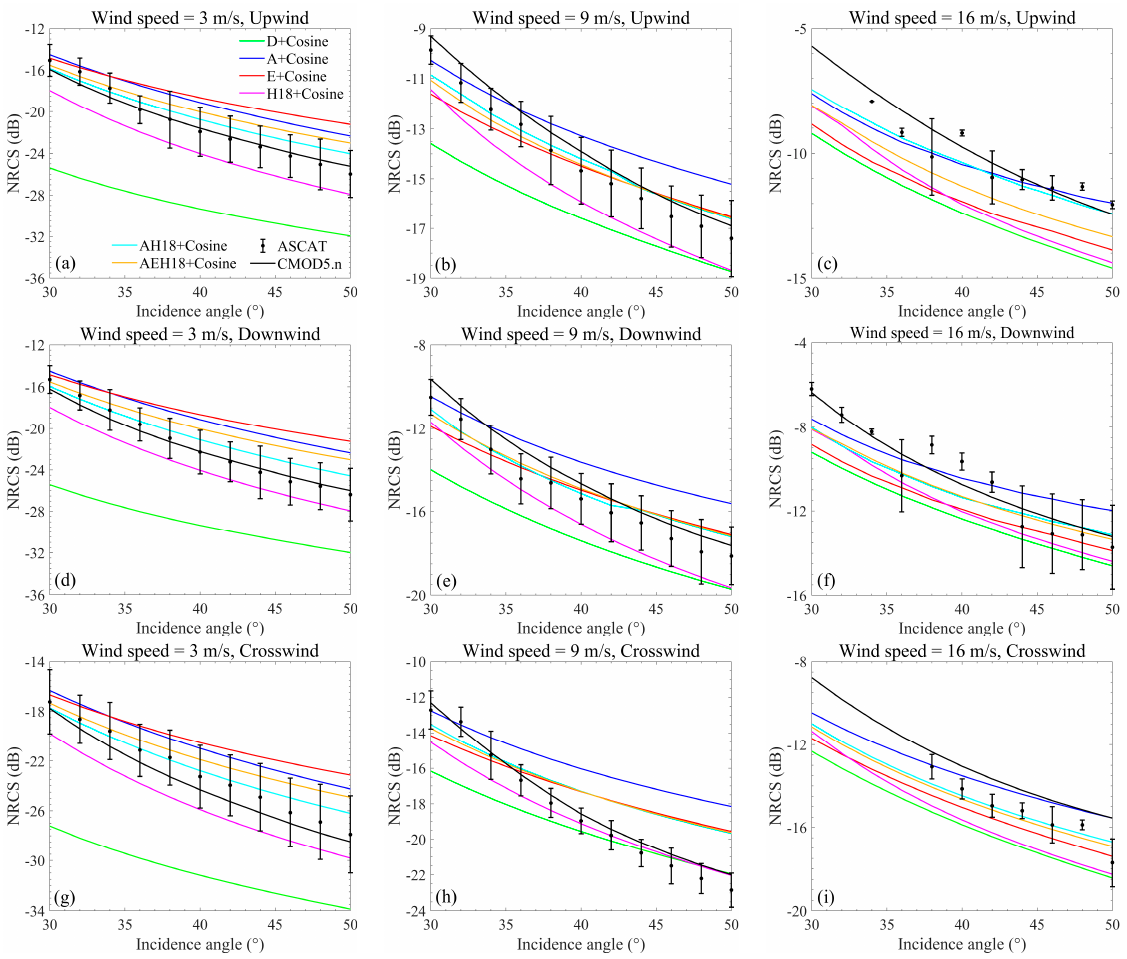
Figure 8. Simulated NRCSs based on D + Cosine, A + Cosine, E + Cosine, H18 + Cosine, AH18 + Cosine, and AEH18 + Cosine, and their comparison with the ASCAT data and CMOD5.n as functions of incidence angle at wind speeds of 3 m/s, 9 m/s, and 16 m/s along the ( a – c ) upwind direction, ( d – f ) downwind direction, and ( g – i ) crosswind direction.